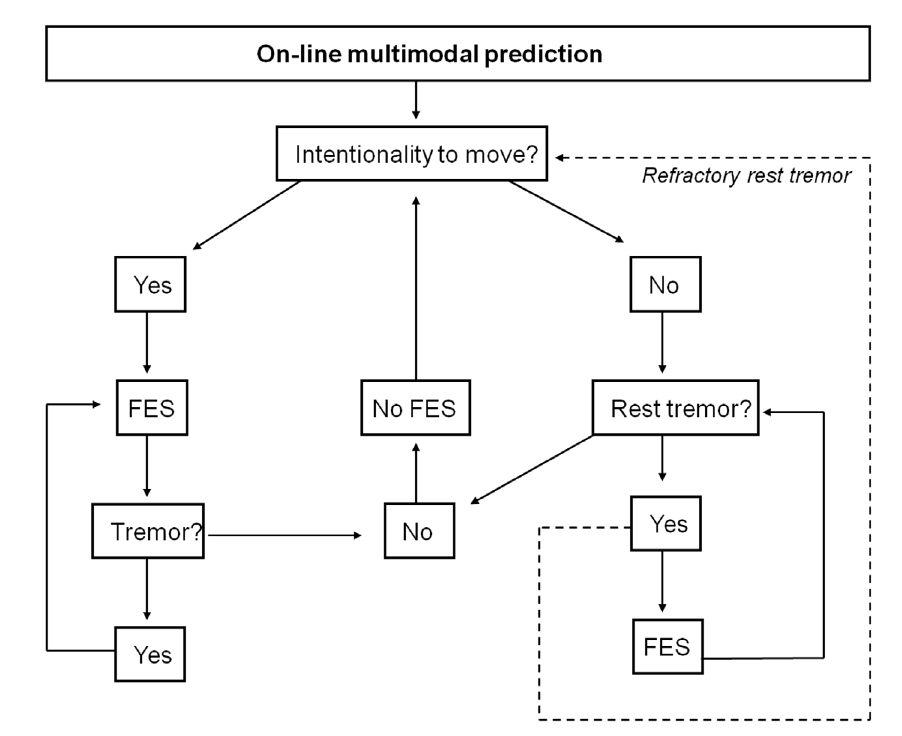
Figure 15. Proposal of a closed-loop approach for the detection of intentionality of movement and the triggering of FES. The detection of the intentionality to move is based on the quality parameters (QPs) reported here. prediction is used to trigger FES once the intentionality to move is detected. Indeed, the various forms of upper limb tremor may react differently to FES due to their distinct pathogenesis.